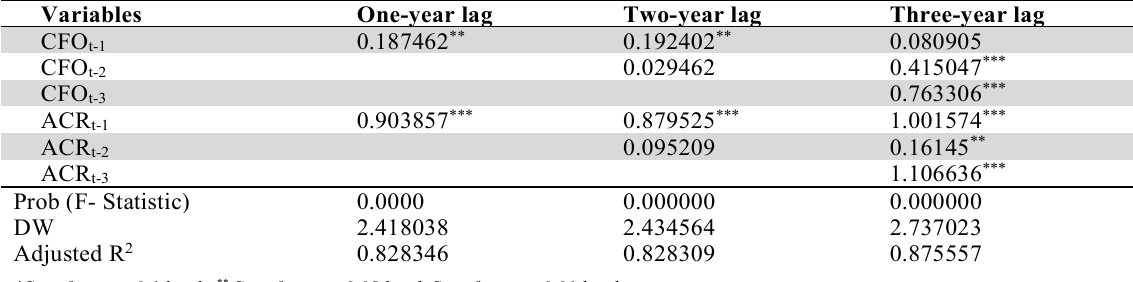
Summary of FEM regression results in the model of cash flows combined with aggregated accruals Variables